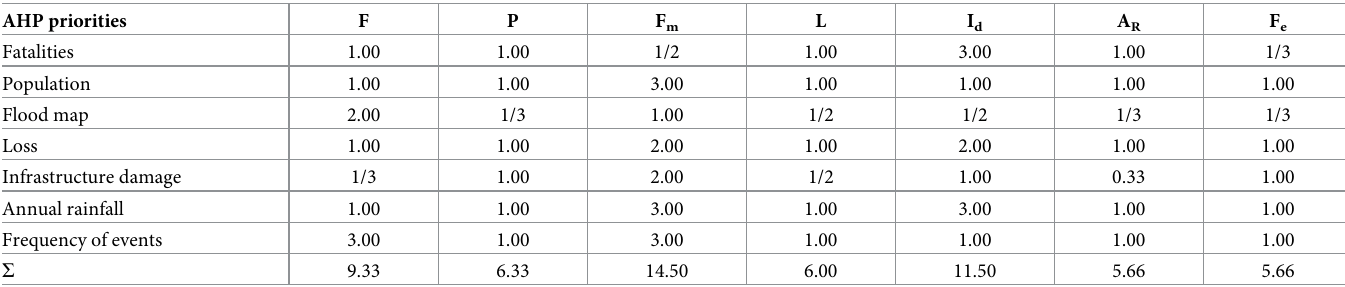
Table 6. AHP priority matrix for DFVI indicators for Chhukha district. AHP